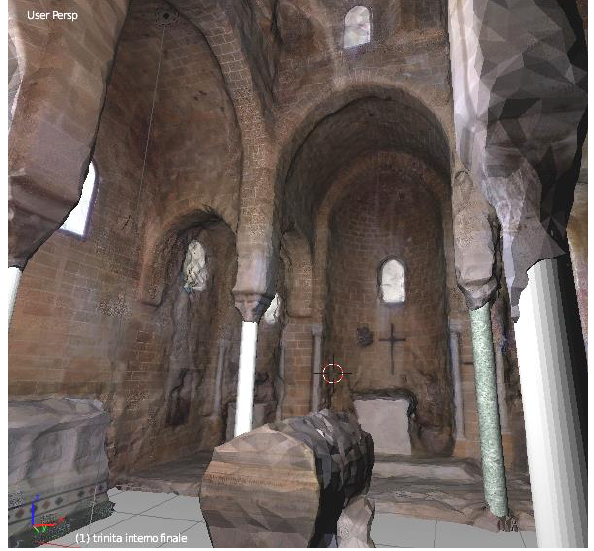
Figure 10. The 3D mesh of the internal model in